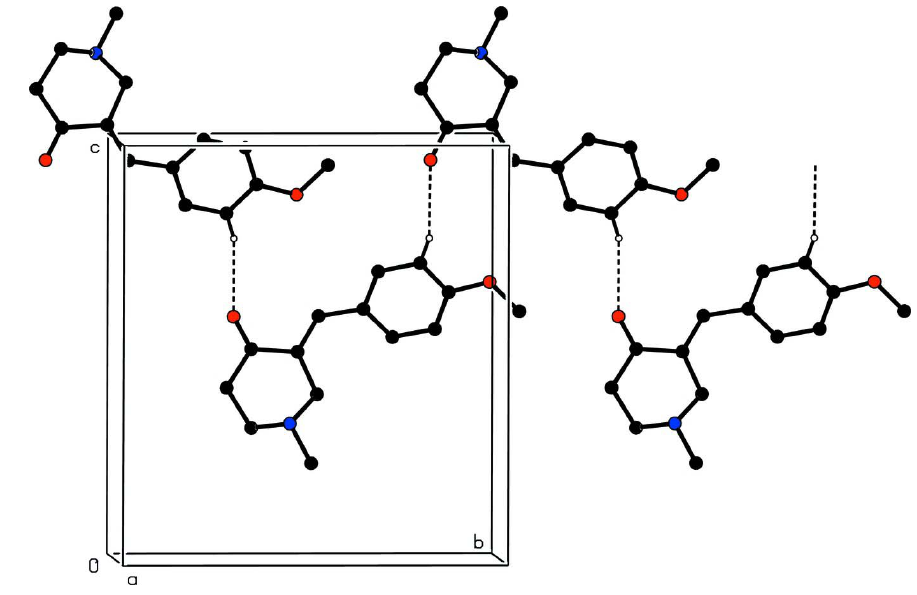
Figure 1 The molecular structure of title compound, showing 30% probability displacement ellipsoids.